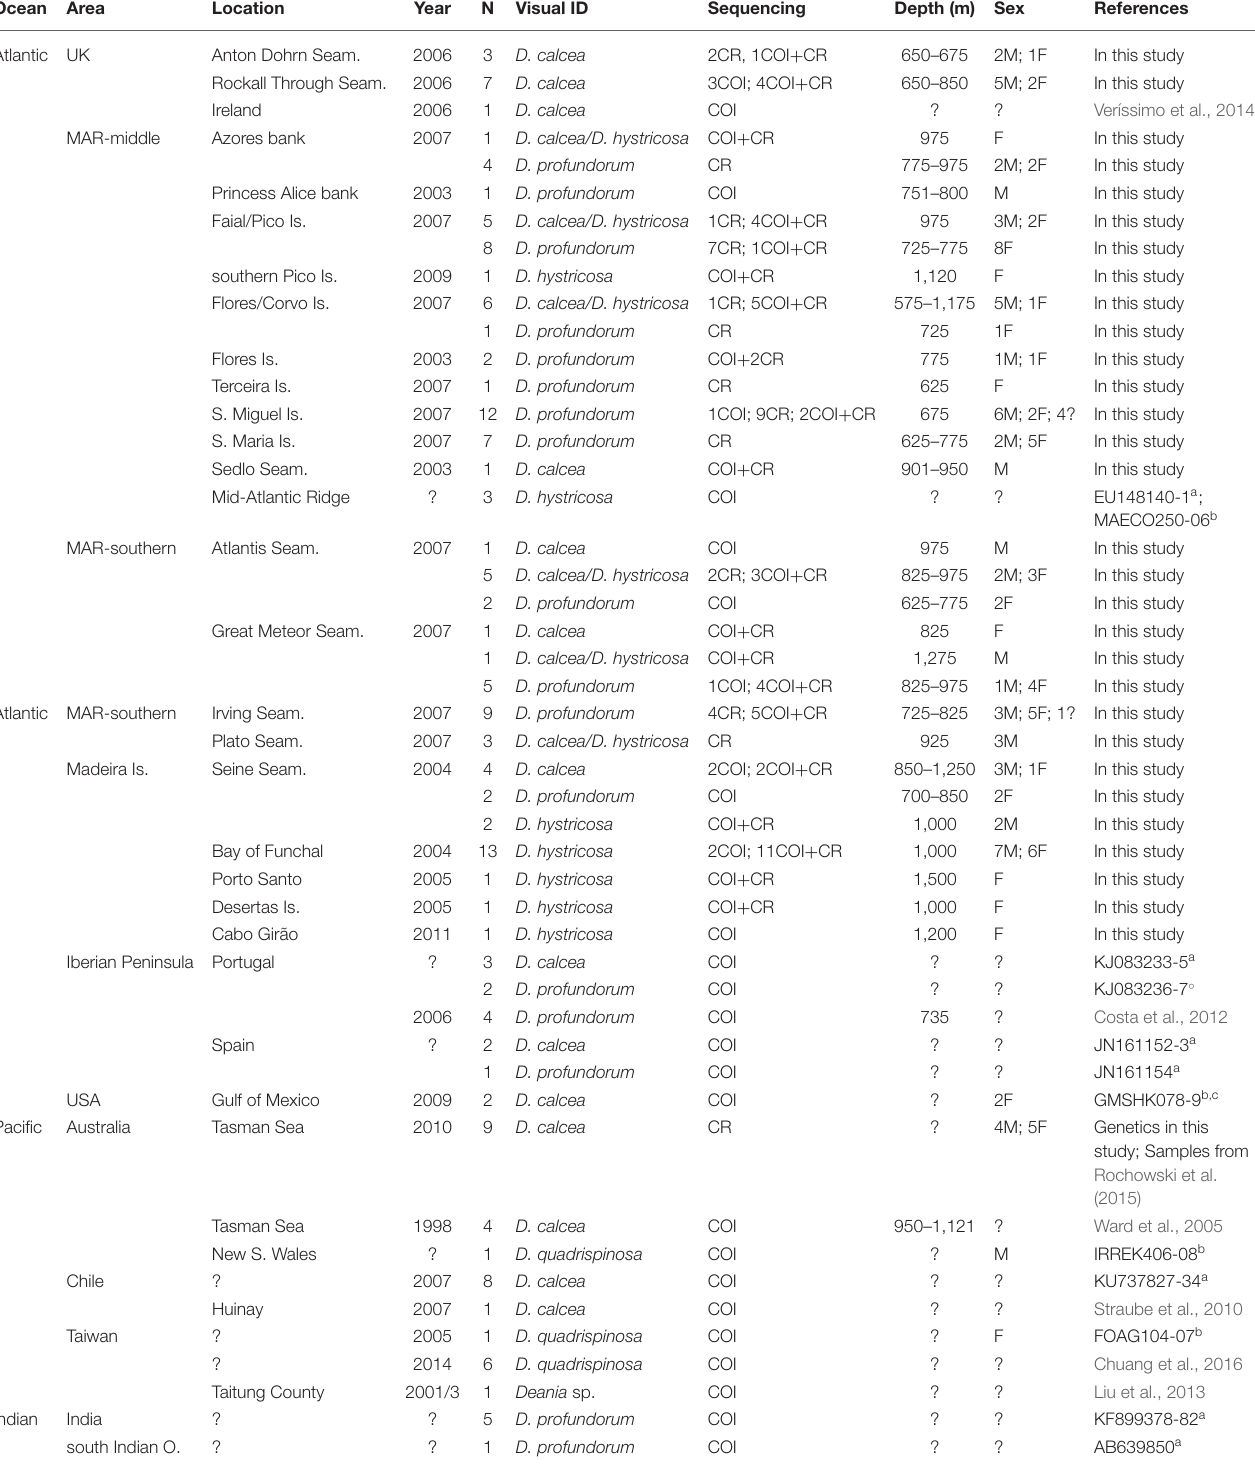
TABLE 1 | List of Deania specimens collected for this study and mtCOI and/or mtCR sequences available in literature or public databases. Ocean